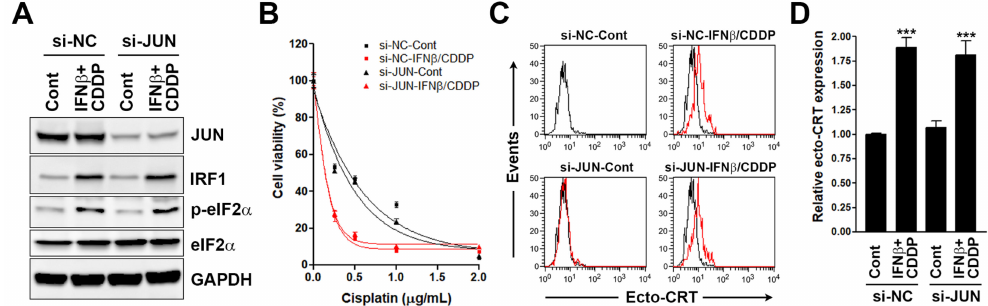
Figure 5. E ff ects of JUN knockdown on sequential interferon β (IFN β )-cisplatin treatment-induced cell viability inhibition and immunogenic cell death (ICD) biomarker expression in HeLa